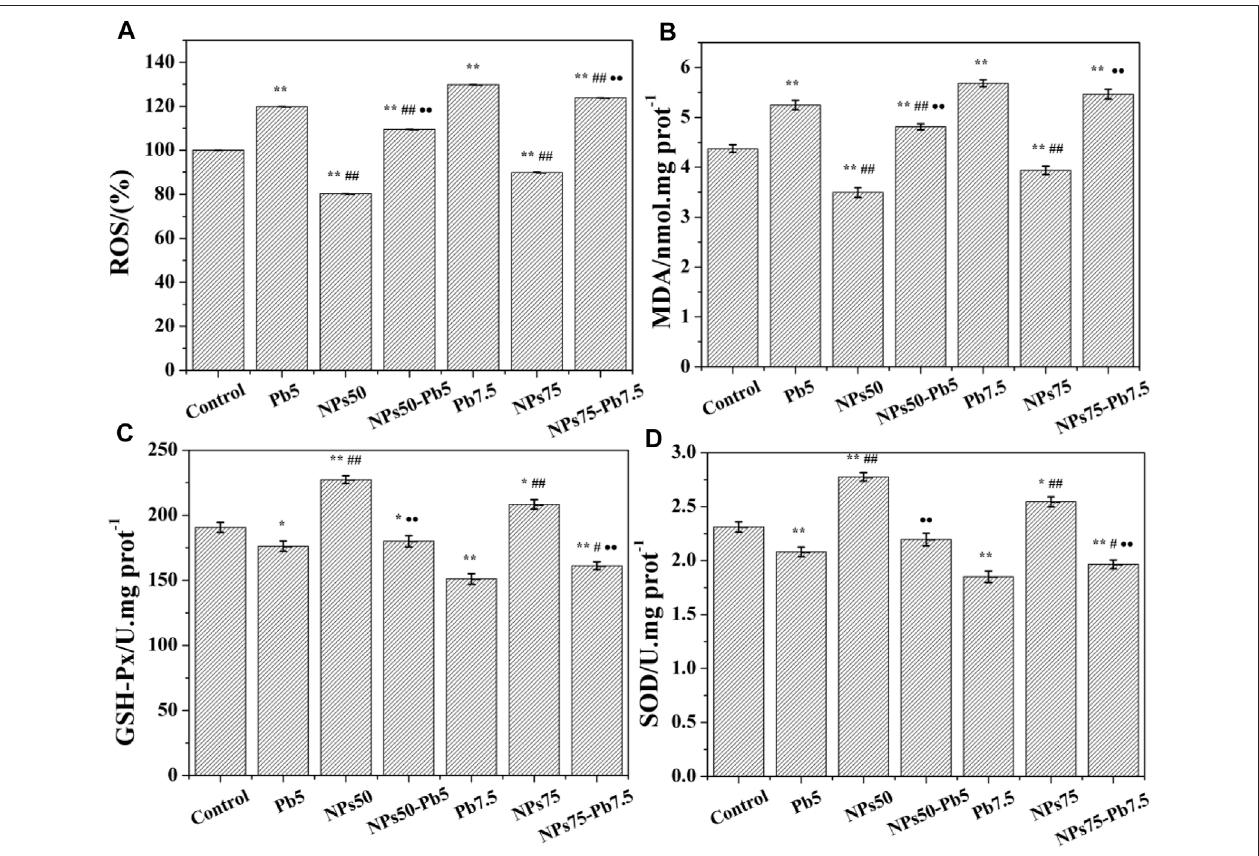
FIGURE 6 | (A) Quantitative level of intracellular ROS. (B) MDA level. (C) Intracellular GSH-Px activity. (D) SOD enzyme activity. * vs. control (* p < 0.05 and ** p < 0.01). # vs. Pb5orPb7.5,correspondingtotheconcentrationofNPsof50or75 μ g mL − 1 ,respectively( # p < 0.05and ## p < 0.01). · vs. NPs50orNPs75,correspondingto the concentration of NPs of 50 or 75 μ g mL − 1 , respectively ( · p < 0.05 and ·· p <